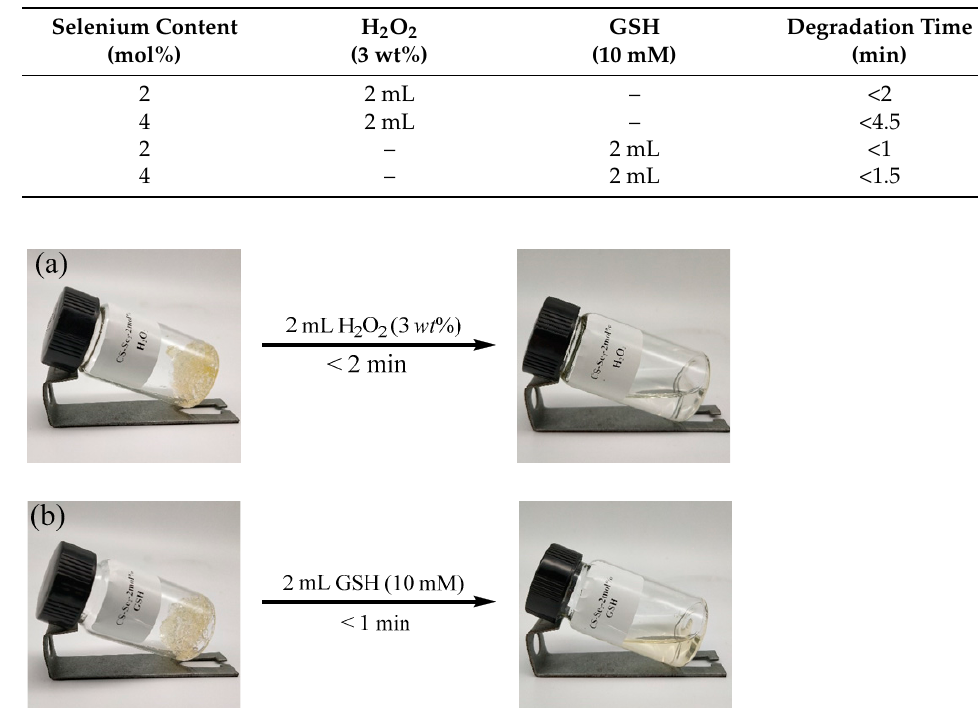
Scheme 2. Schematic illustration for on demand dissolution of the hydrogel relies on the oxidation or reduction of diselenide bonds by H 2 O 2 or GSH, respectively. Table 1. Dissolution of the 2 mol% and 4 mol% Se-containing chitosan hydrogel by H 2 O 2 or GSH respectively.